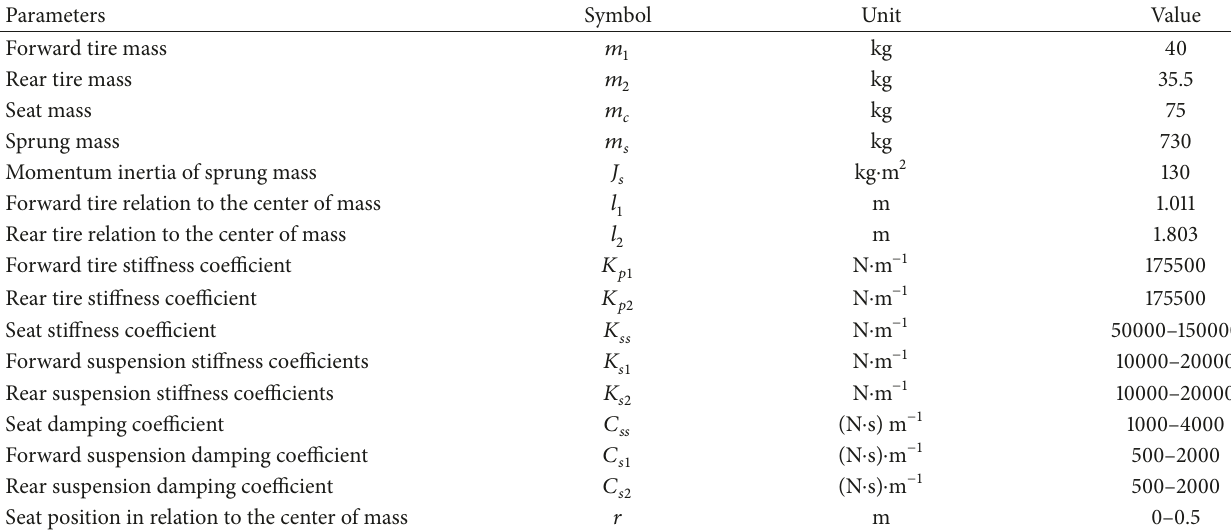
Table 4: Vehicle parameters.